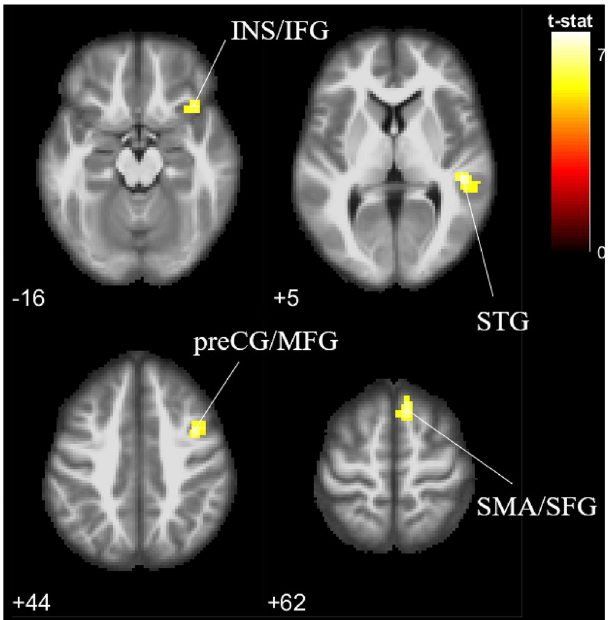
Figure 3. Brain activation to own infant versus non-own ethnic in-group infant faces (OI > IG), p < 0.05 (FWE corrected). INS insula, IFG inferior frontal gyrus, STG superior temporal gyrus, preCG precentral gyrus, MFG middle frontal gyrus, SMA supplementary motor area, SFG superior frontal gyrus.